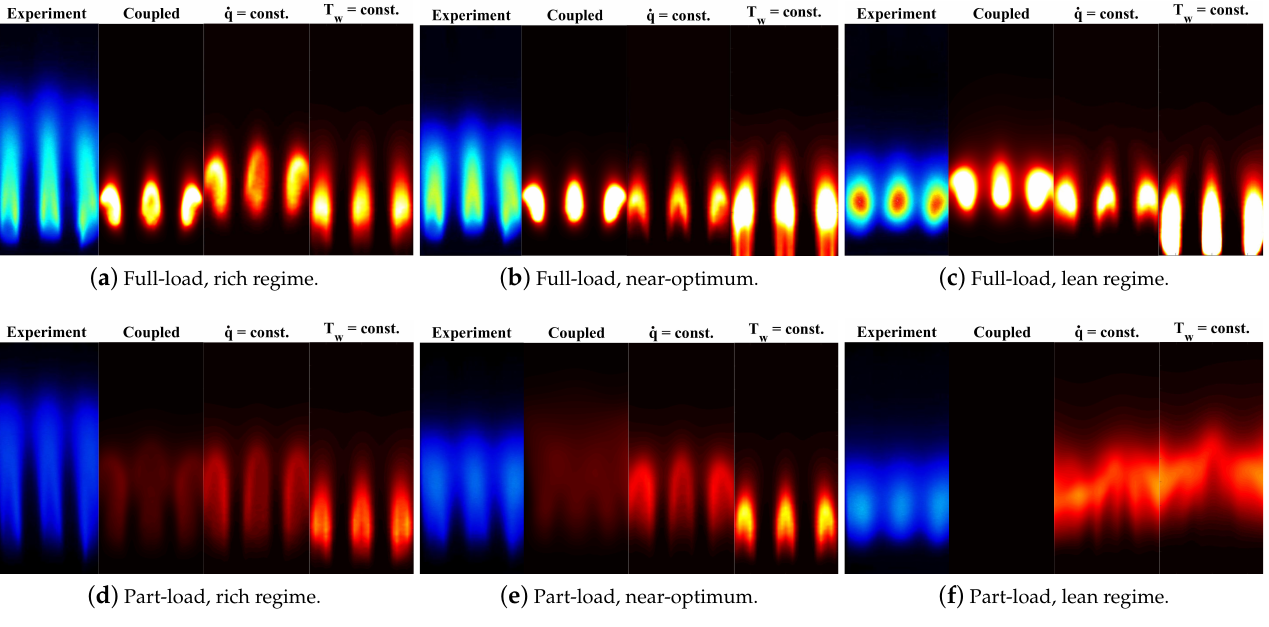
Figure 9. Comparison of experimental and numerical results for OH * for nominal base- and part-load conditions. Subfigure titles from left to right : Experiment, Coupled, ˙ q = const., T W =